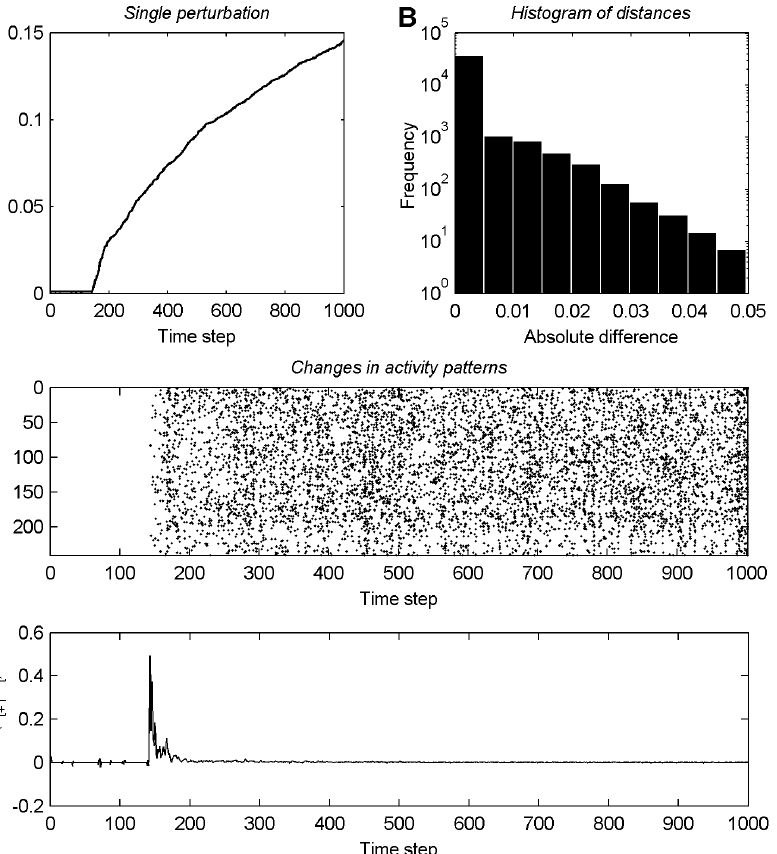
Figure 3. Example of a single amplified perturbation. A Development of the normalized Euclidean distance in a single perturbation during the decay phase. B Histogram of the single absolute differences of the excitatory-to-excitatory weights at time step 1,000 in A. C Differences in neuron activity patterns between the perturbed and the unperturbed network. D Time course of ln( d t z 1 = d t ) . d t corresponds to the normalized Euclidean distance in A at time step t .